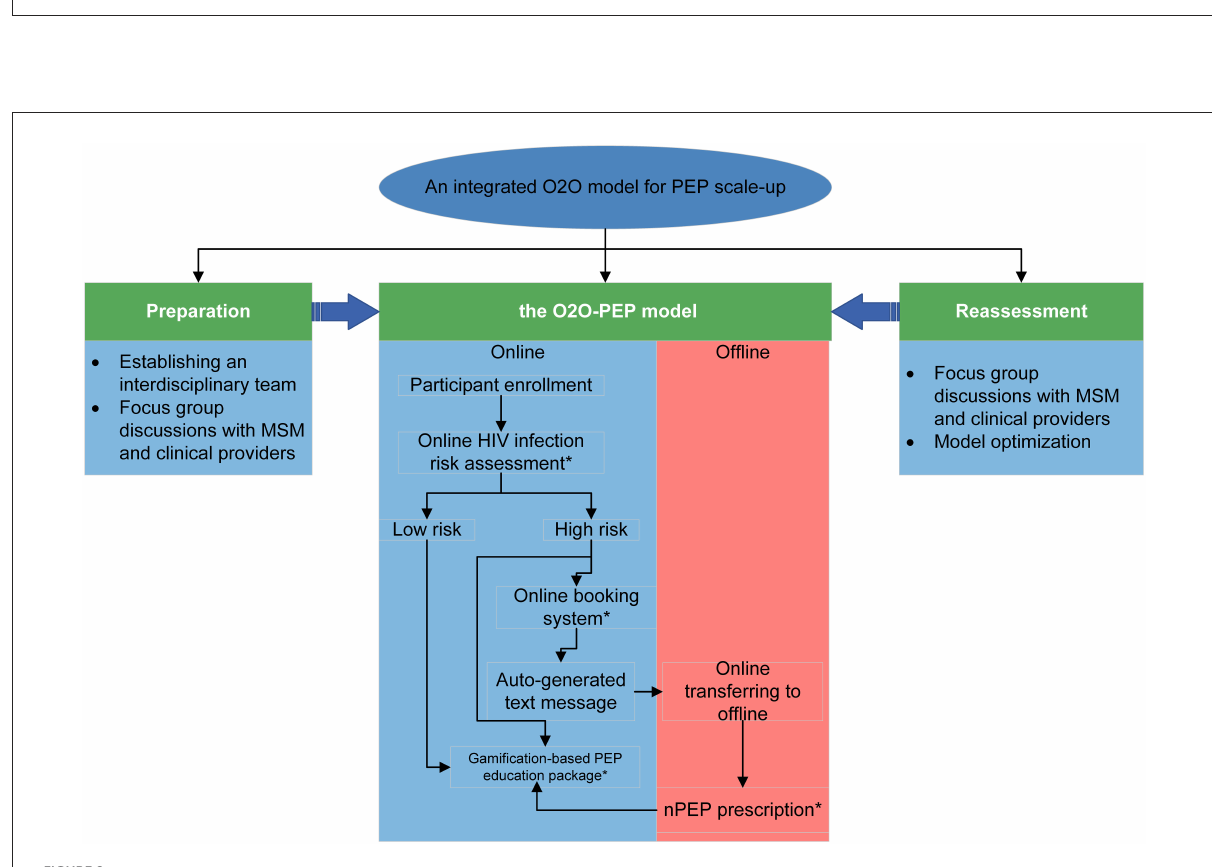
FrontiersinPublicHealth